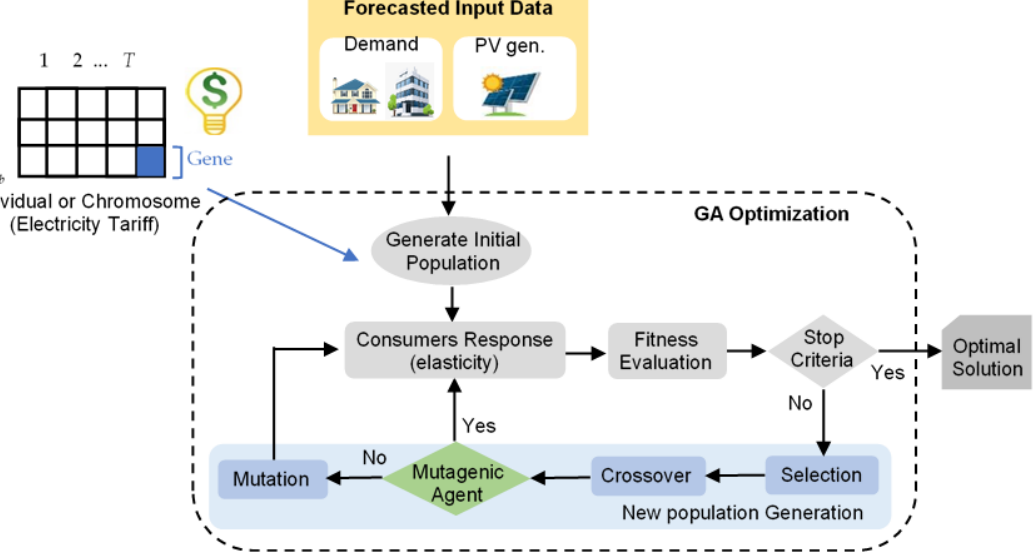
Figure 1. Demand response methodology based on the genetic algorithm.